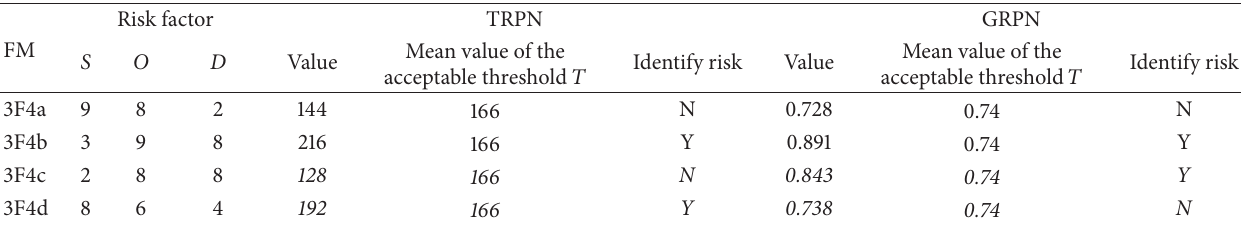
Table 12: Comparison of the TRPN and GRPN test procedures—scenario